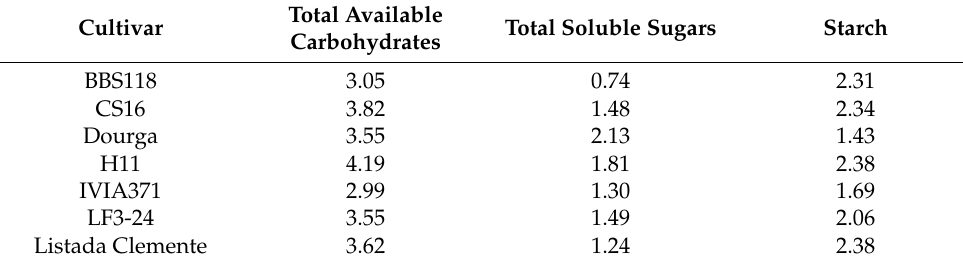
Table 7. Carbohydrate content in the seven eggplant cultivars (g/100 g) [44].